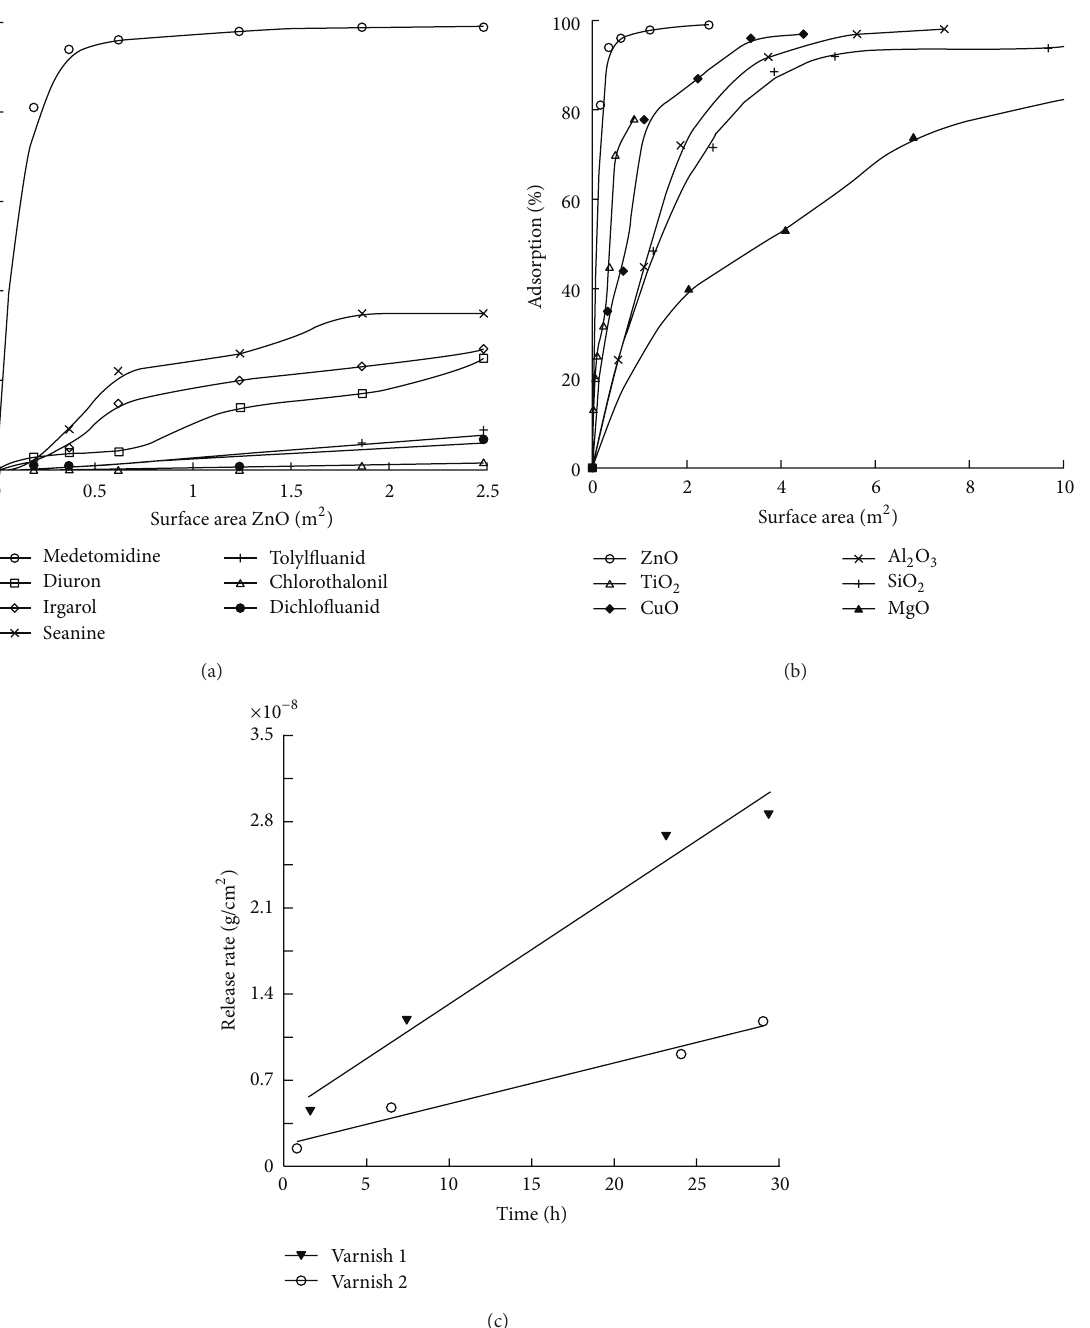
Figure 7: (a) Immobilization efficiency of various booster biocides including medetomidine (see Scheme 1) on ZnO nanoparticles as a function of total particle surface area. (a) Immobilization efficiency of medetomidine on various metaloxide nanoparticles as a function of total particle surface area. (c) Effect on release of free (varnish 1, 󳶃 ) and ZnO immobilized (varnish 2, I ) medetomidine from coatings. Reprinted from